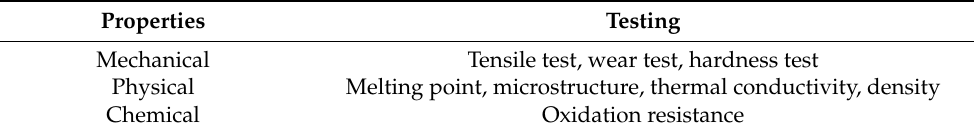
Table 10. Material properties and type of